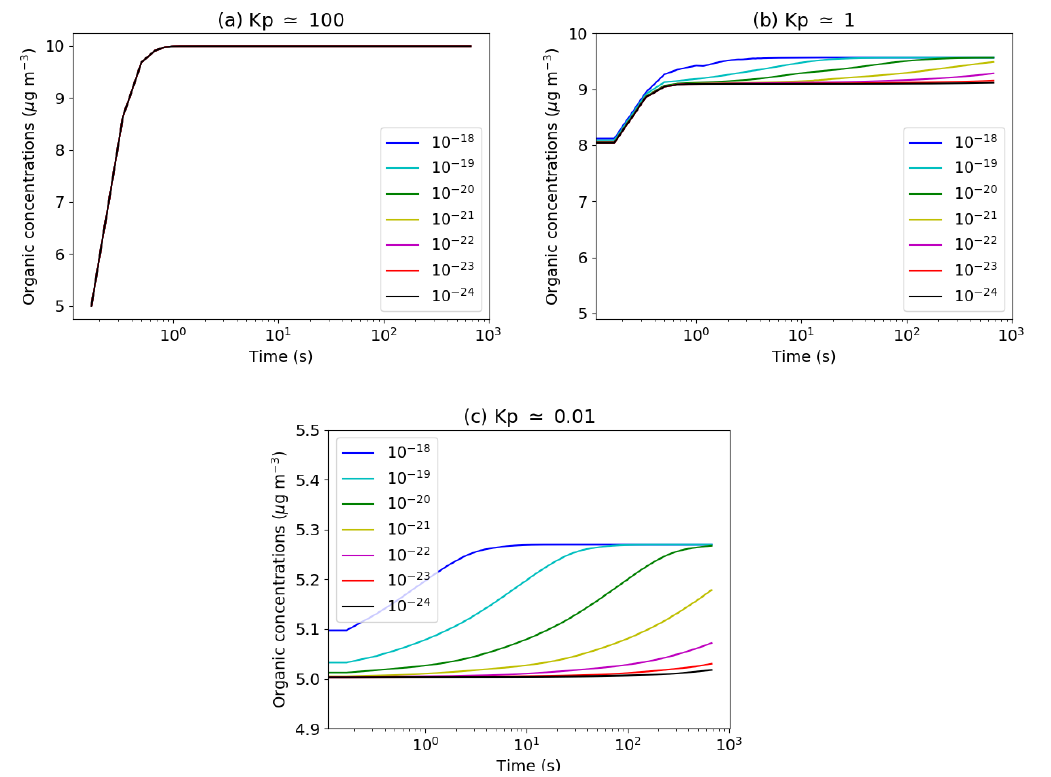
Figure 6. Viscosity test case: time evolution of organic concentrations (( a ) SOAlP; ( b ) POAlP; and ( c ) POAmP) for several organic-phase diffusivities: 10 − 18 (dark blue), 10 − 19 (light blue), 10 − 20 (green), 10 − 21 (yellow), 10 − 22 (magenta), 10 − 23 (red) and 10 − 24 (black) m 2 s − 1 . In terms of computing time, compared to the internal mixing case, the coagulation test case is 16 times slower when discretising the composition into four sections, and the condensation test case is 13 times slower when discretising the composition into 10 sections.